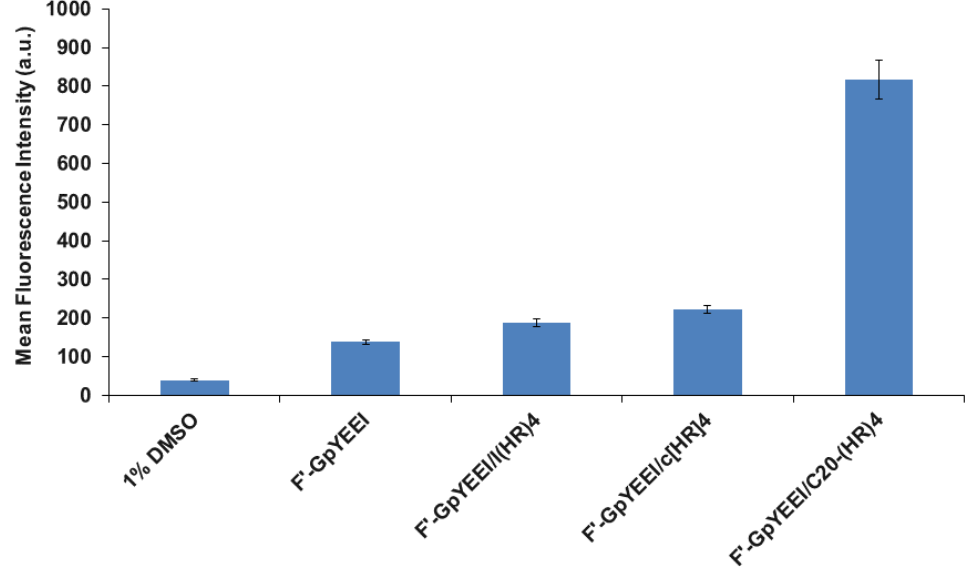
Figure 8. The cellular uptake of F’-GpYEEI at 5 µM concentration by C 20 -(HR) n peptides at 50 µM peptide concentration in CCRF-CEM cell line.